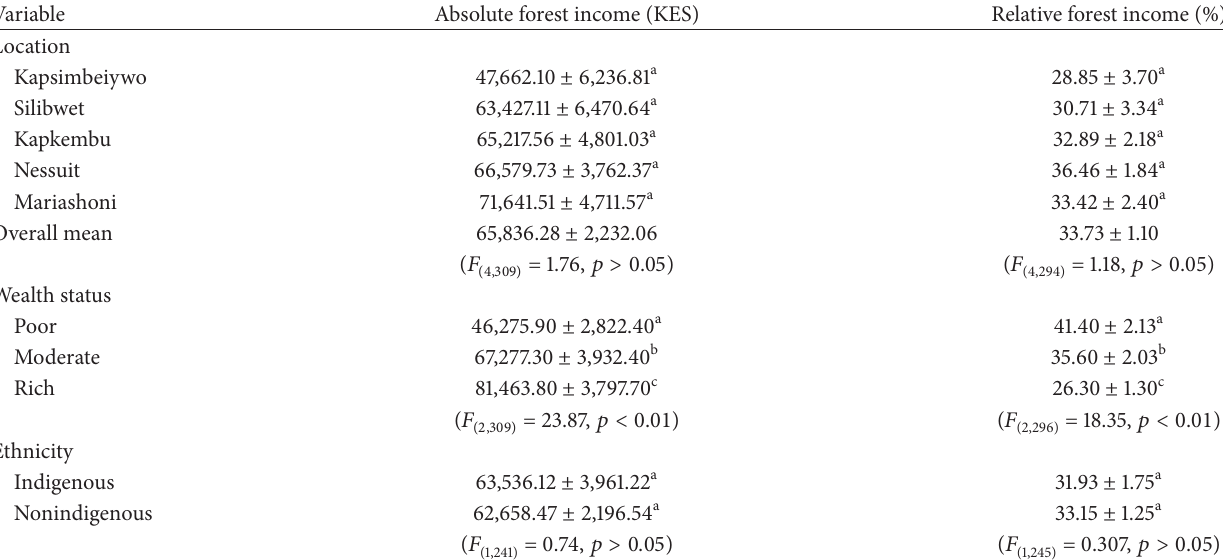
Table 5: Absolute forest income, relative forest income (%) by study location, wealth status, and